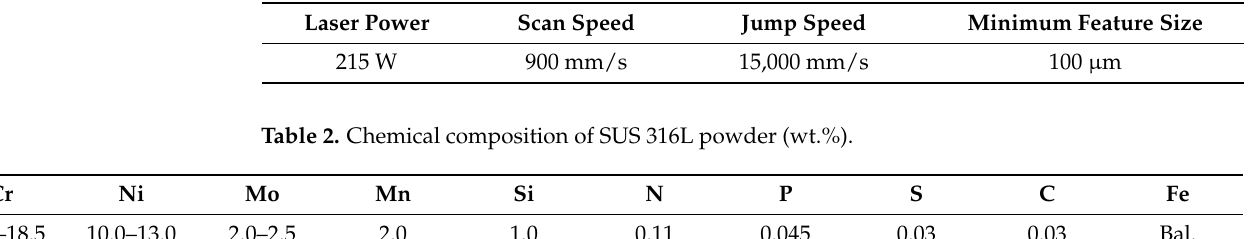
Table 1. Process parameters of PBF 3D printer.